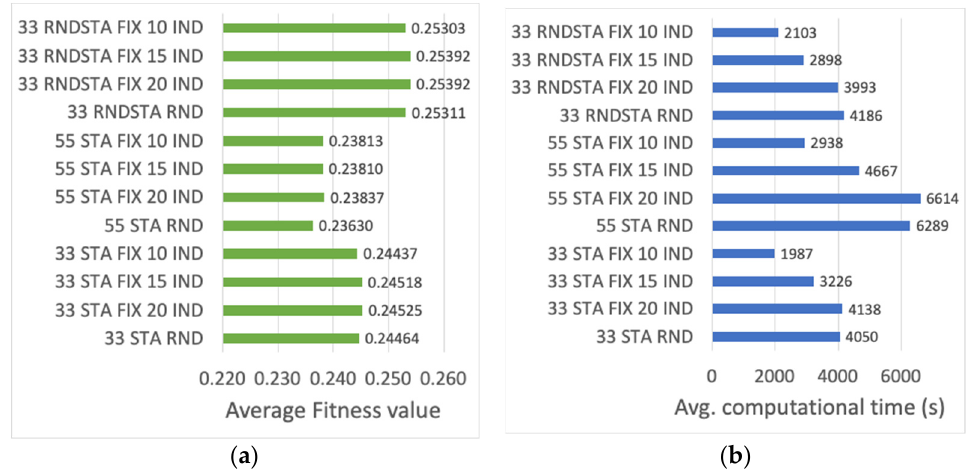
Figure 10. ( a ) Average fitness value of the best individual, ( b ) average computational time (s), for different initial populations. different initial